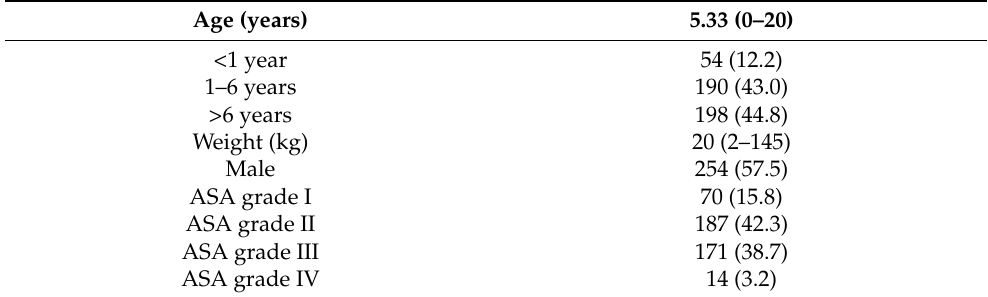
Table 1. Demographic characteristics of 442 patients.